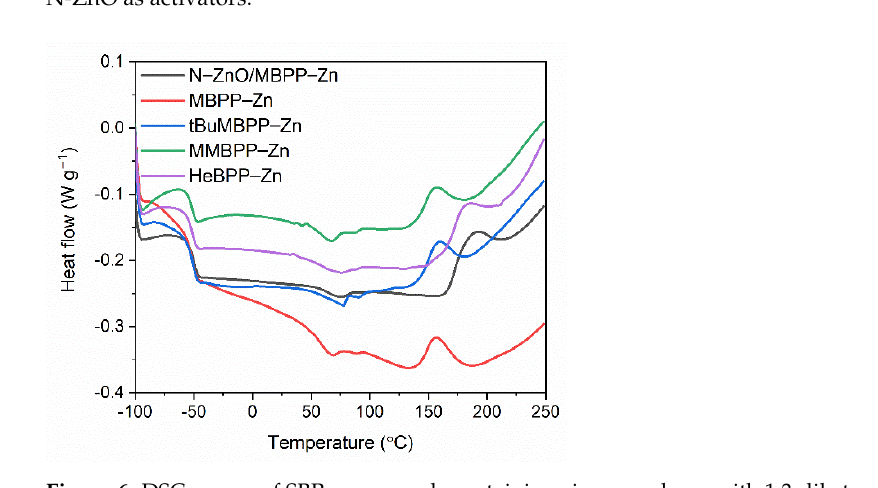
Figure 6. DSC curves of SBR compounds containing zinc complexes with 1,3-diketones as activators.